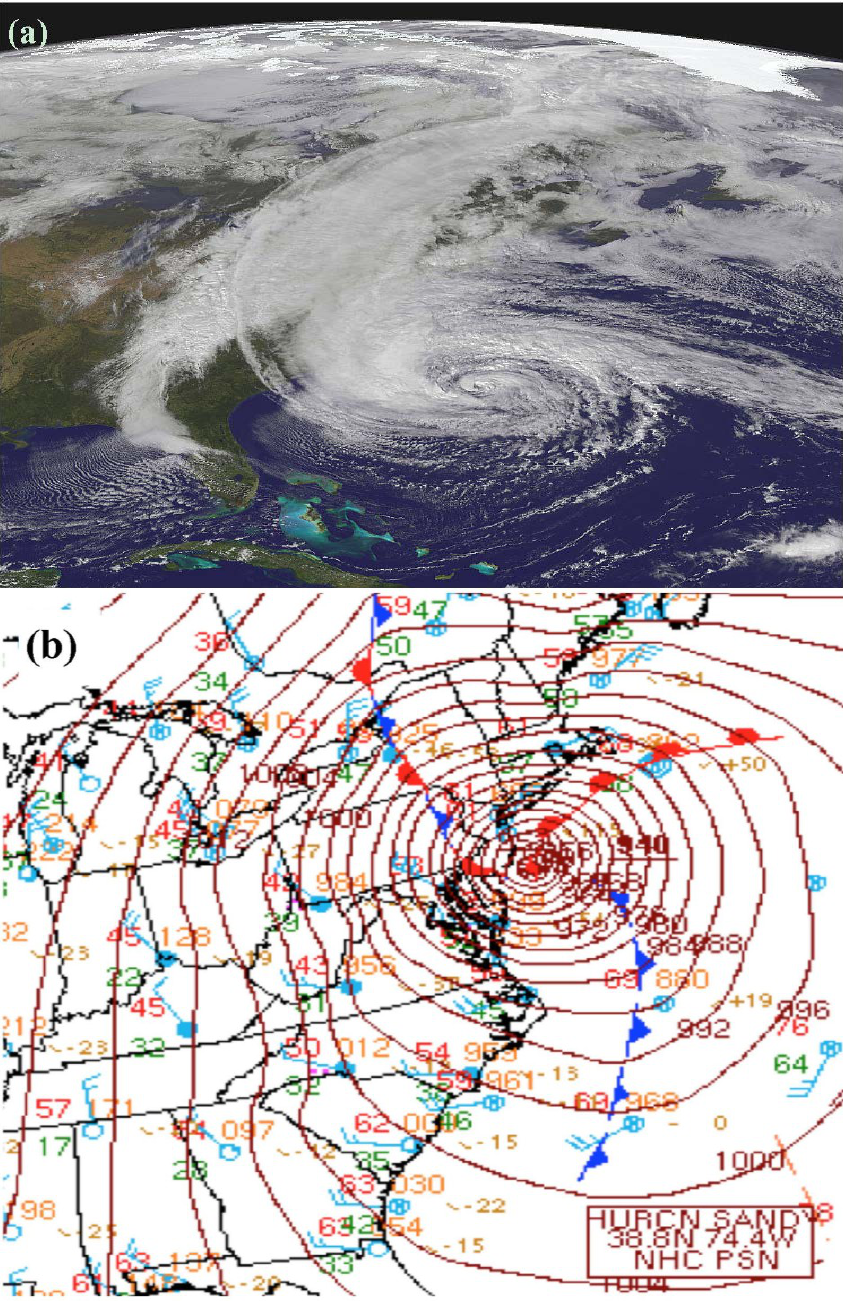
Figure 1. ( a ) GOES-13 natural color satellite image at 17:45 UTC on 28 October 2012 (courtesy of NASA Earth Observatory); and ( b ) surface weather chart at 21 UTC 29 October 2012, approximately two and a half hours before landfall (courtesy of the National Oceanic and Atmospheric Administration (NOAA)). Note the interaction of the hurricane with the approaching winter storm, the subsequent drop in mean sea level pressure to 940 mb, and the development of cold and warm fronts during the hybridization process off the coast of New